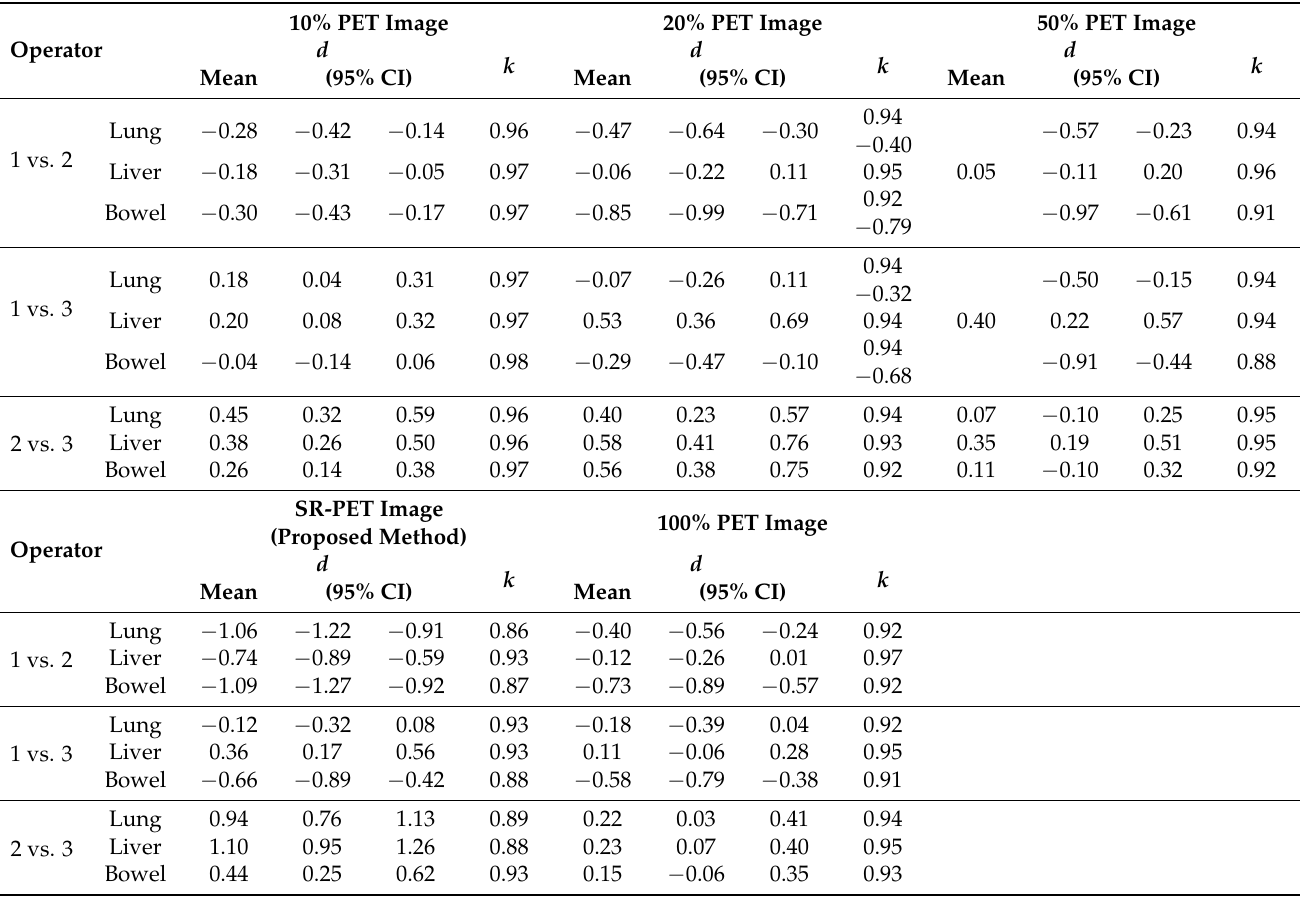
Table 3. Summary of agreement of inter-operator variance using Cohen’s weighted kappa ( k )